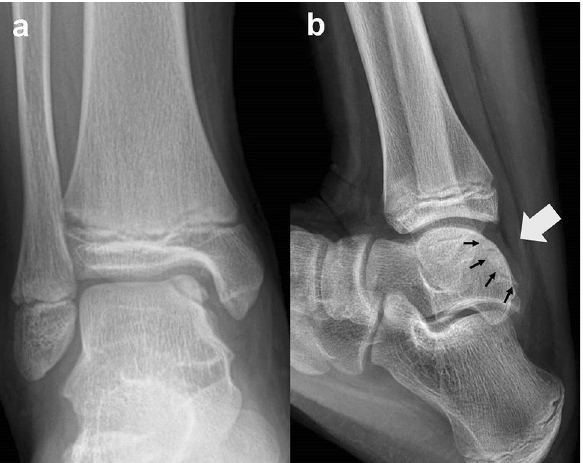
Figure 1. ( a ) A 13-year-old male patient with a large osteochondral fragment located on the medial talar dome was treated by internal fixation. (b ) Maximal dorsiflexion of the ankle exposed the osteochondral fragment out of the tibiotalar articulation, which enabled internal fixation through a posteromedial arthrotomy without a malleolar osteotomy. The black arrows indicate the margin of the lesion. The white arrow indicates that the lesion could be approached from the posterior side through an